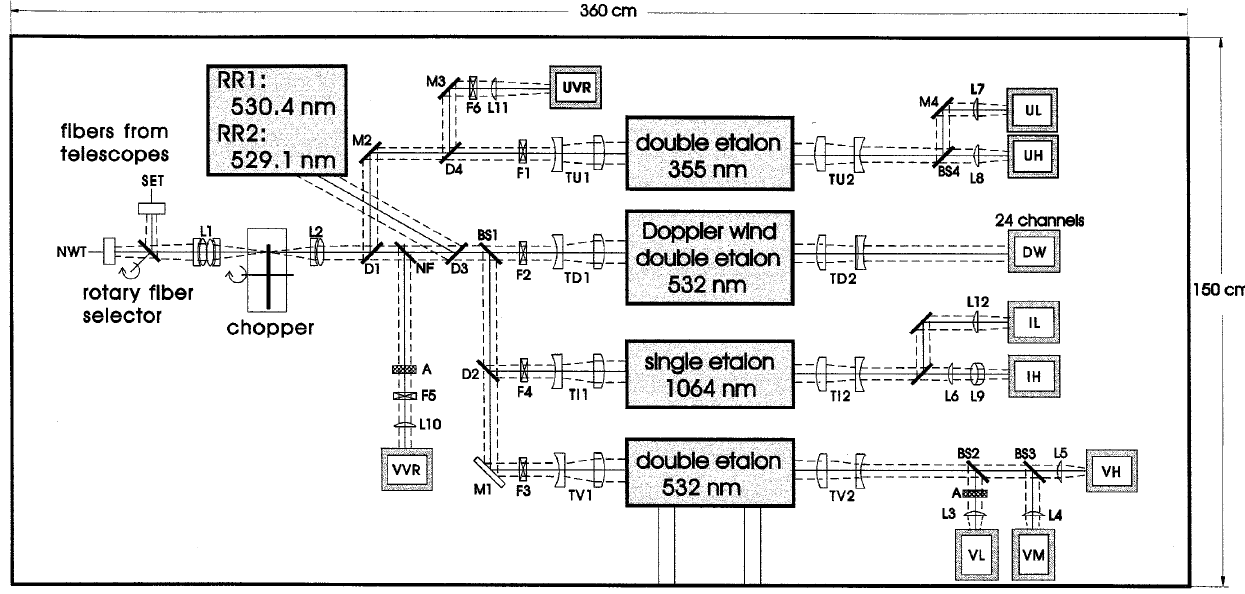
branches, corresponding to 355, 532, and 1064 nm. Photons which were vibrationally Raman scattered on N are isolated by the notch 2 filter NF and interference filter F5 (for 608 nm) and the dichroic D4 and interference filter F6 (for 387 nm). Rotationally scattered photons are isolated through dichroic D3 . Each of the four etalon units is placed between beam widening and narrowing telescopes. The detector assembly DW behind the Doppler wind etalon consists of 24